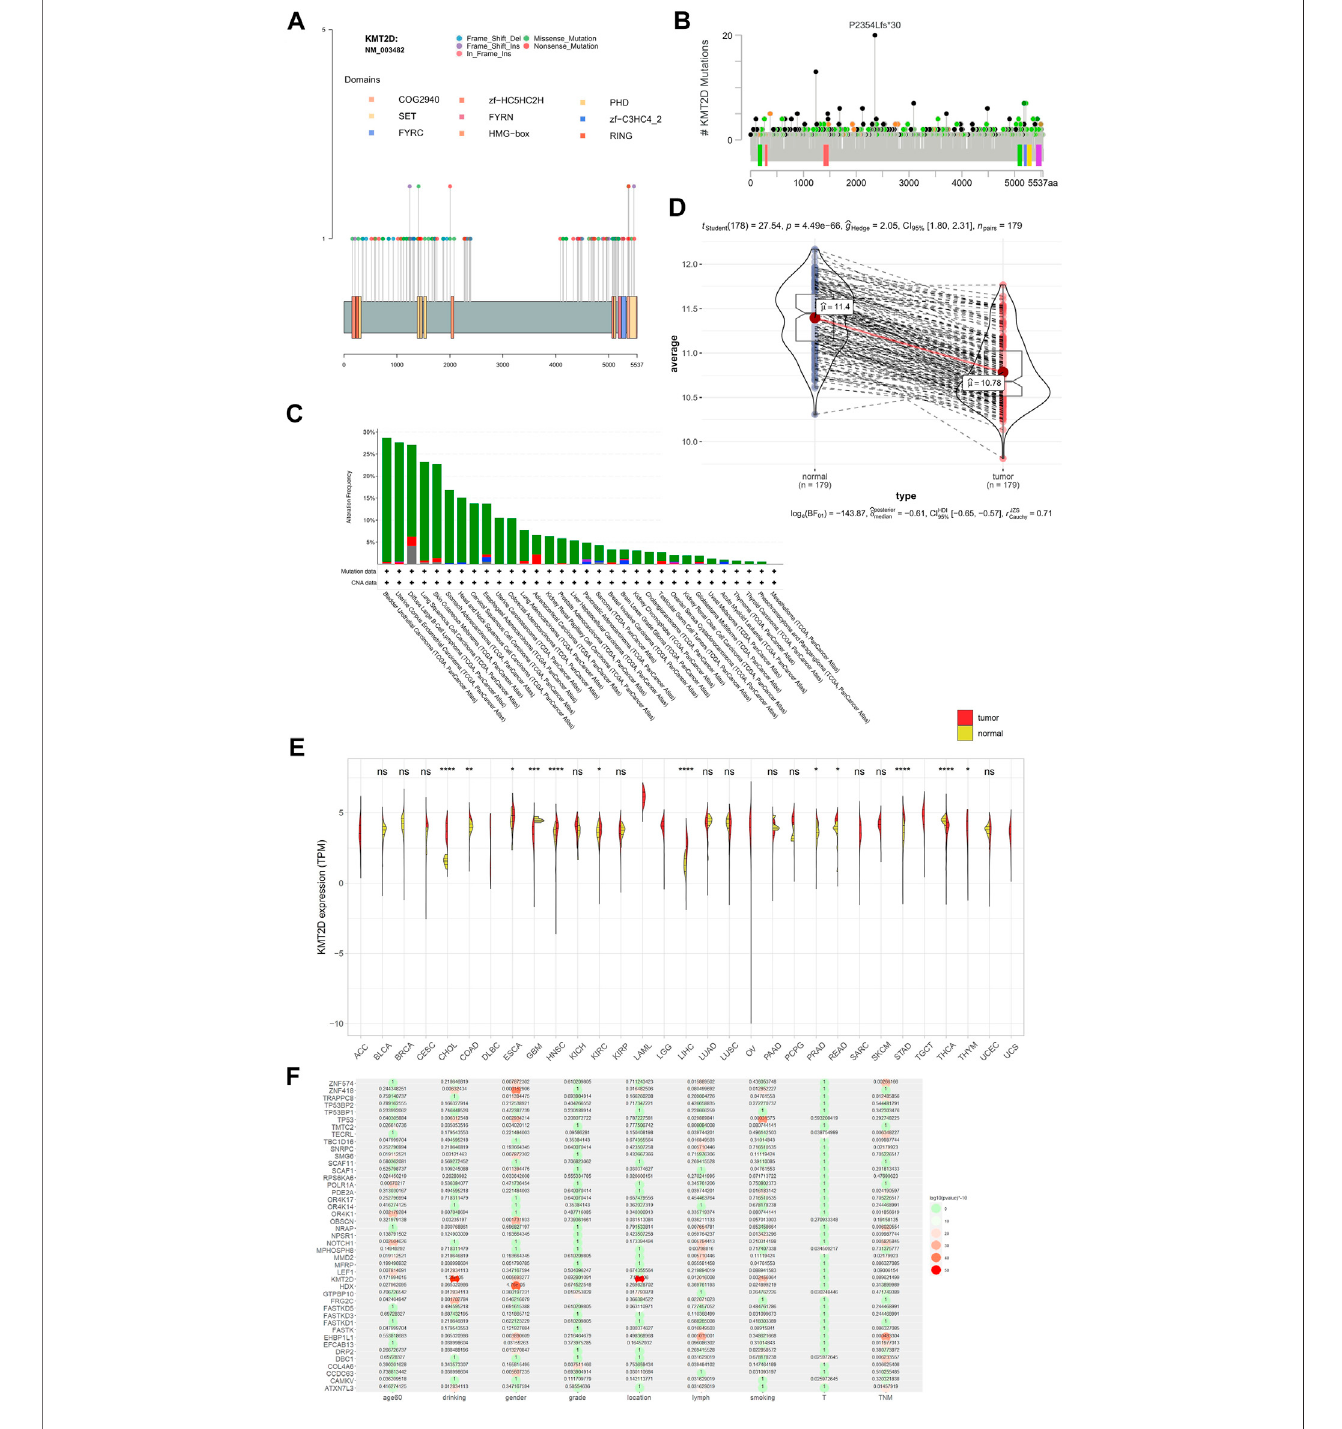
FIGURE 7 | KMT2D mutation, KMT2D expression and the correlation between KMT2D mutation and clinical characteristics. (A) KMT2D mutation in ESCC, (B) KMT2D mutation in TCGA, (C) mutation and CNV of KMT2D in TCGA cancer, (D) the expression of KMT2D in tumor and normal of ESCC in the GSE53625, (E) expression of KMT2D in TCGA cancer, (F) the correlation of gene mutation with clinical characteristics.